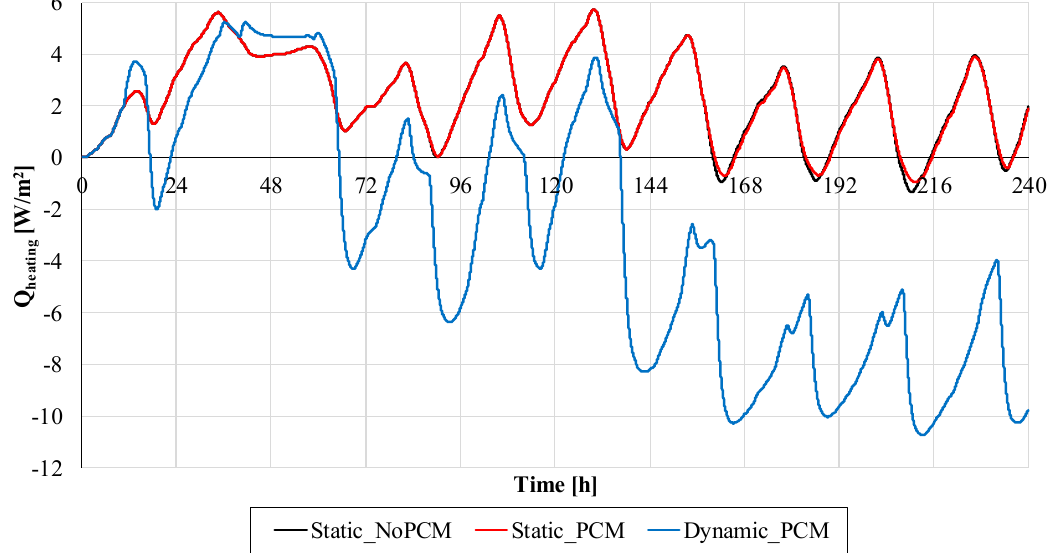
Figure 6. Evolution of heating load for the different analysed systems when implemented in the ASHRAE (Wall2) envelope.